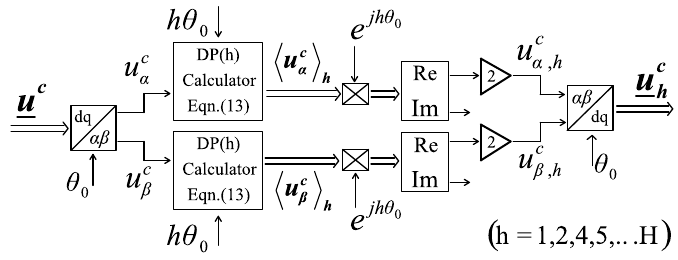
Figure 2. Extraction of the capacitor bank’s harmonic voltage